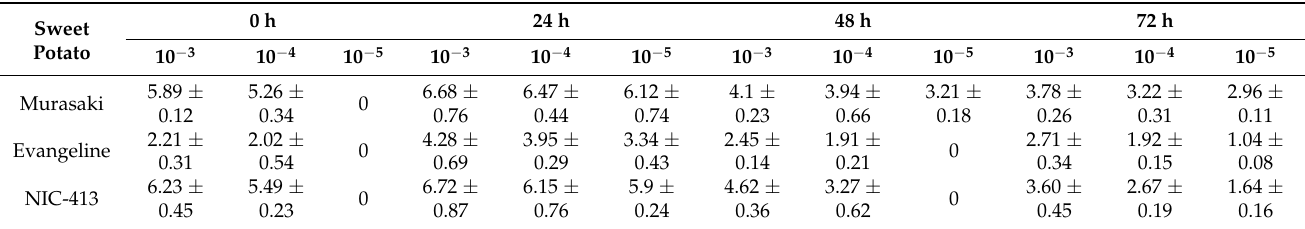
Table 6. Viable cell count (Log CFU/mL) of Lactiplantibacillus plantarum with three different dilutions (10 − 3 , 10 − 4 , 10 − 5 ). in fermented sweet potato samples at 0, 24, 48, and 72 h fermentation time points. Sweet Potato